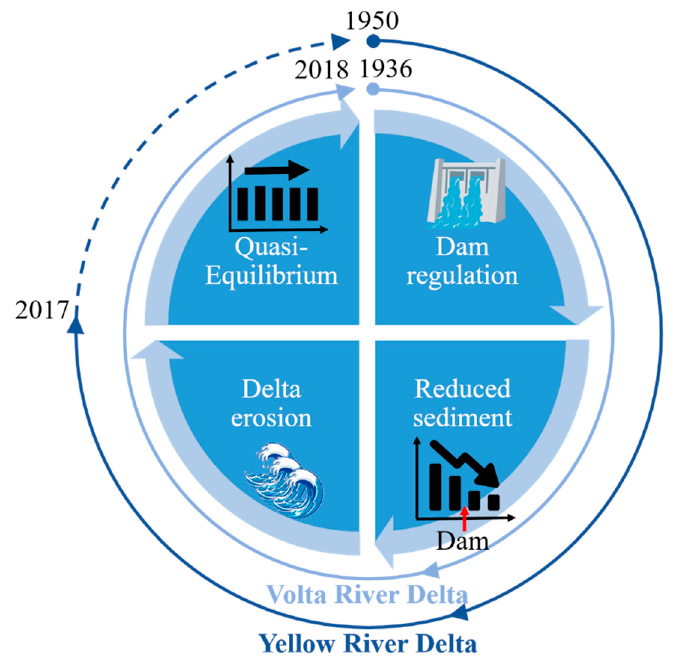
Figure 9. A conceptual model summarizing the overall effects of dam regulation for deltaic hydro- logical alteration and morphological evolution.